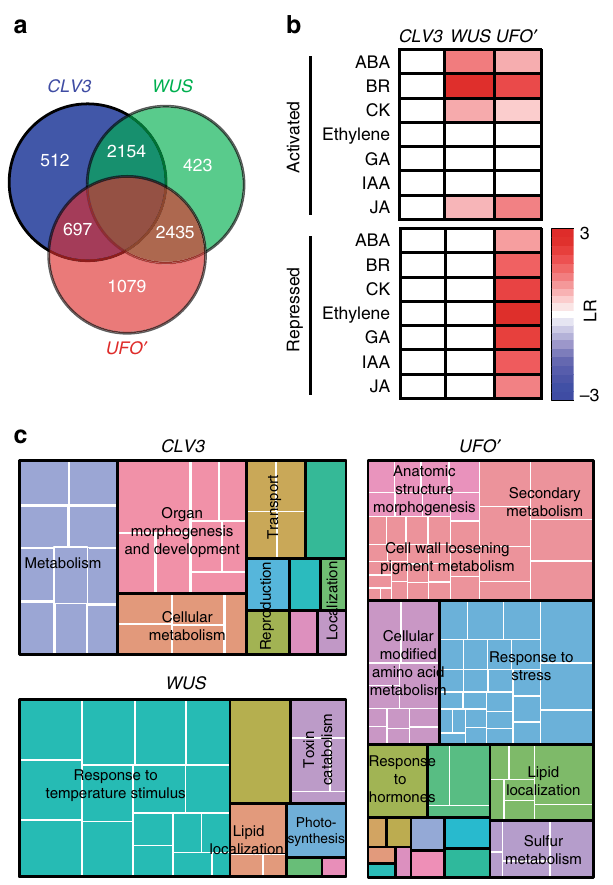
Fig. 6 Gene expression pattern among SAM domains. a Differentially expressed genes among different domains in the SAM. All differentially expressed genes between any two meristem domains with FC ≥ 2, FDR ≤ 0.01 were used for the analysis. Domain-speci fi c genes are those enriched when compared with the other two domains. b Domain-speci fi c enrichment of hormone-activated and -repressed genes among the three SAM domains. Only signi fi cantly over-represented hormone categories by a hypergeometric test with a FDR correction (adjusted P value ≤ 0.05) are colored with log 2 scaled odds ratio (LR). c GO analysis of domain-speci fi c genes, which indicates function-related enrichment in different domains summarized using REVIGO. Aggregate size indicates signi fi cance levels in the GO term by the Yekutieli test with FDR correction